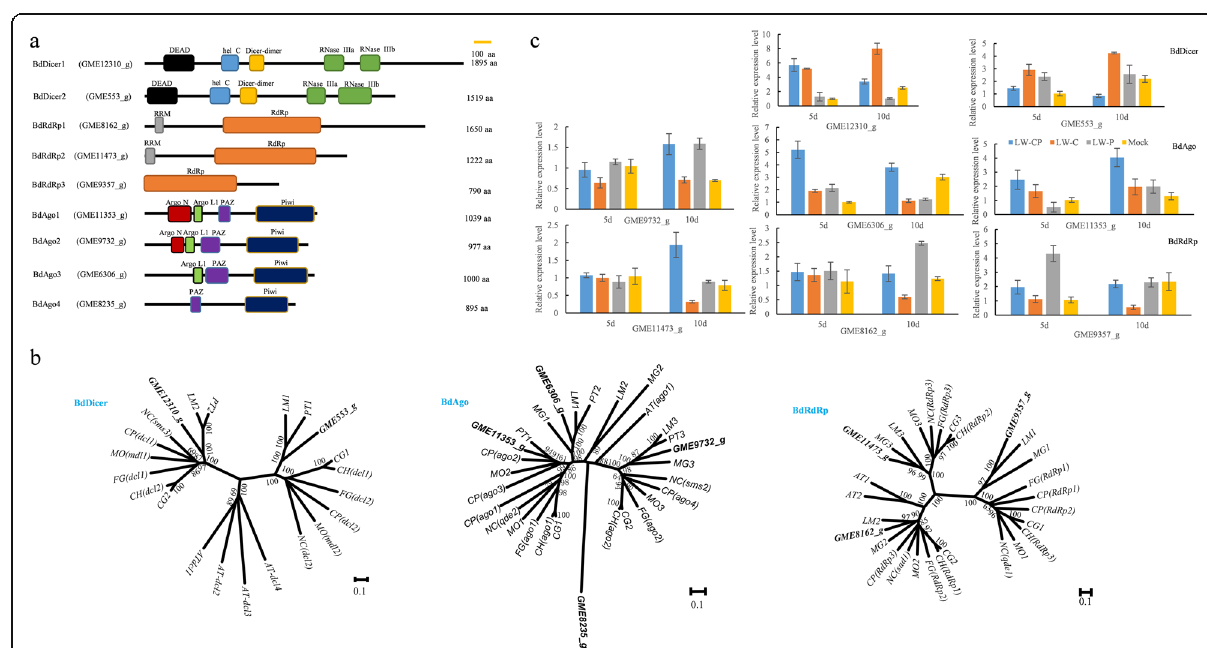
Fig. 7 Sequence and expression analyses of the RNA-silencing components of Botryosphaeria dothidea. a Predicted domain structure of dicer (DCL), RNA-dependent RNA polymerases (RdRps) and argonaute (Ago) proteins in B. dothidea LW-Hubei strain. Lines represent the full length of proteins. Boxes represent the identified domains and are labeled with different colors. b Phylogenetic analyses of dicer (left), RdRps (right), and Ago (middle) protein sequences from B. dothidea and homologous proteins from representative members of other fungi. Counterparts from Arabidopsis thaliana served as the outgroup member. Rooted maximum likelihood neighbor-joining trees with 1000 bootstrap replicates were constructed by alignment of full-length protein sequences. The accession numbers for dicer, RdRps, and AGO protein sequences from representative members used in the alignment are listed in Additional file 30: Table S14. c Analysis of BdDicer, BdRdRp and BdAgo gene expression in mycovirus- infected B. dothidea LW-Hubei strains. Values were normalized to the mean actin gene (GME8592_g)